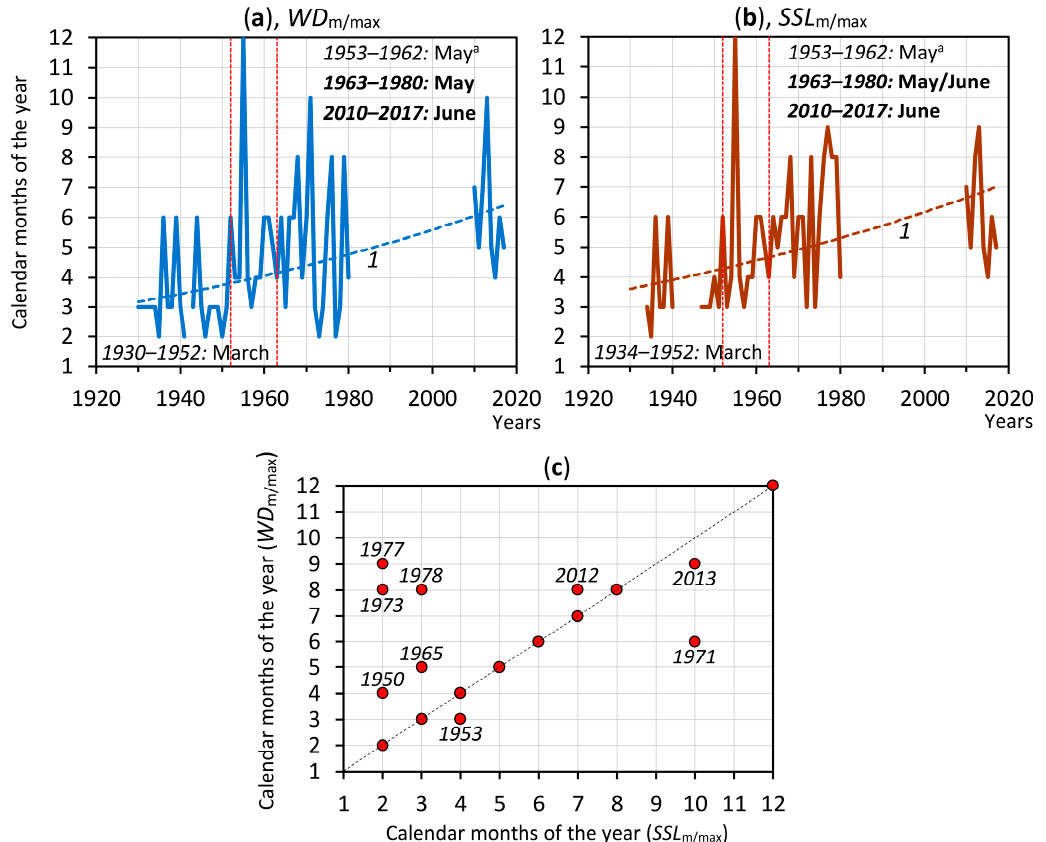
Figure 9. Temporal shift tendencies in the month with the maximal mean monthly water discharge ( a ; WD m/max ) and suspended sediment load ( b ; SSL m/max ) of the Kalaus River at the town of Svetlograd (see Figure 1; Table 1) from the 1930s to 2017. 1 —the power trend line; ( c ) graphical linear correlation between WD m/max and SSL m/max . a Hereinafter, the averaged month for the corresponding